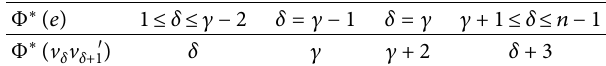
Table 6: Edge labeling of Φ ∗ ( e )